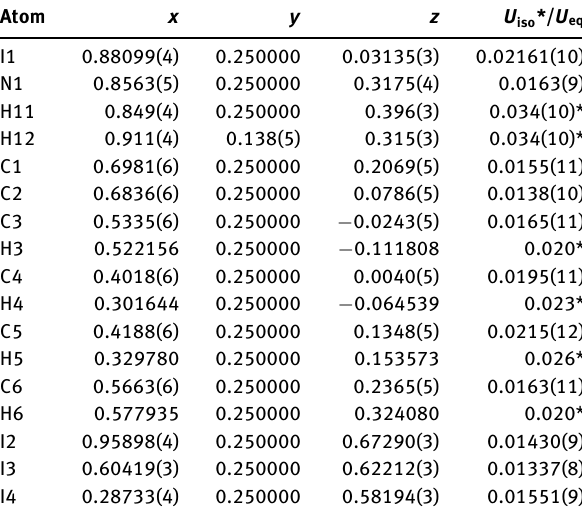
Table 2: Fractional atomic coordinates and isotropic or equivalent isotropic displacement parameters (Å 2